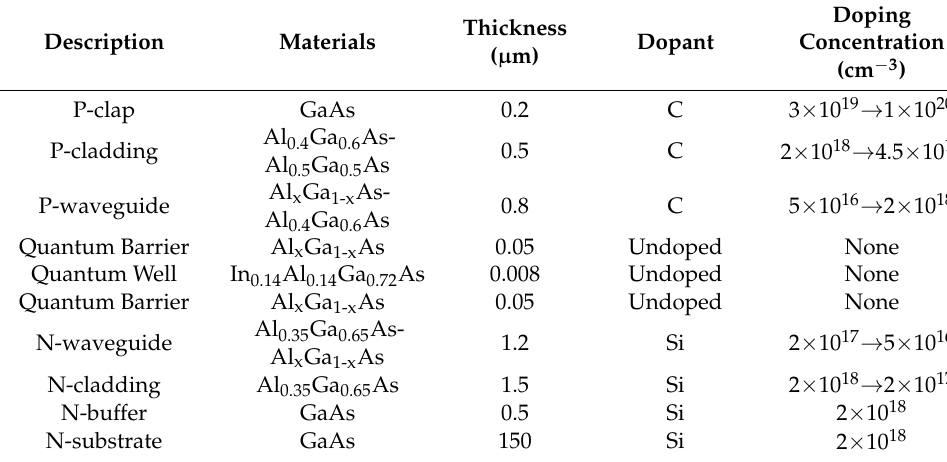
Table 2. Optimized epitaxial structure [22].